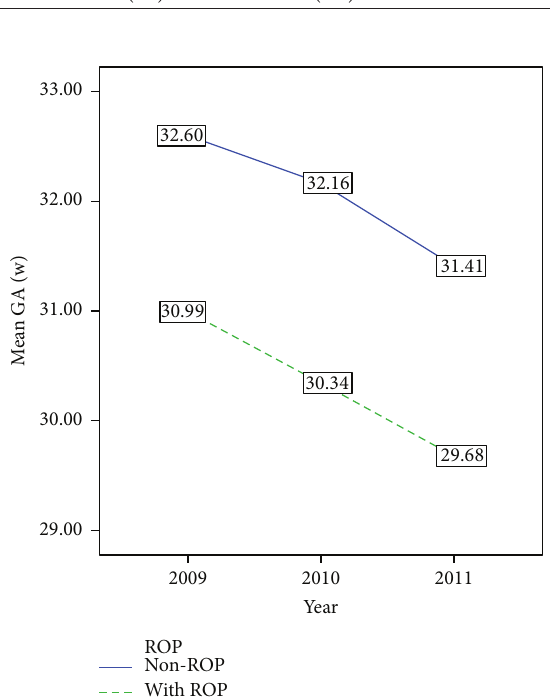
Figure 2: The mean birth weight of ROP and non-ROP infants in 2009, 2010, and 2011.